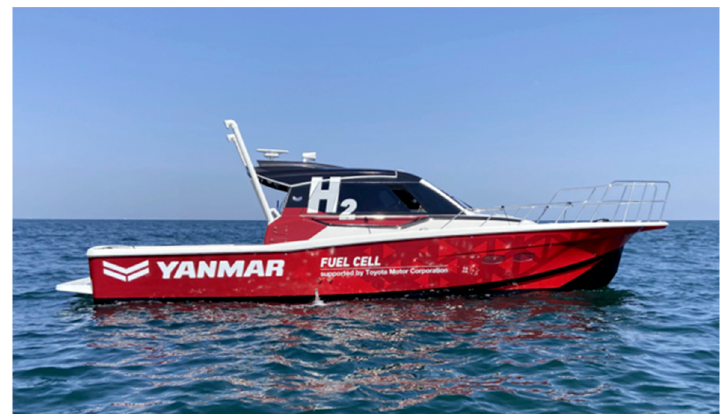
Figure 28. The yacht “EX38A” [133].